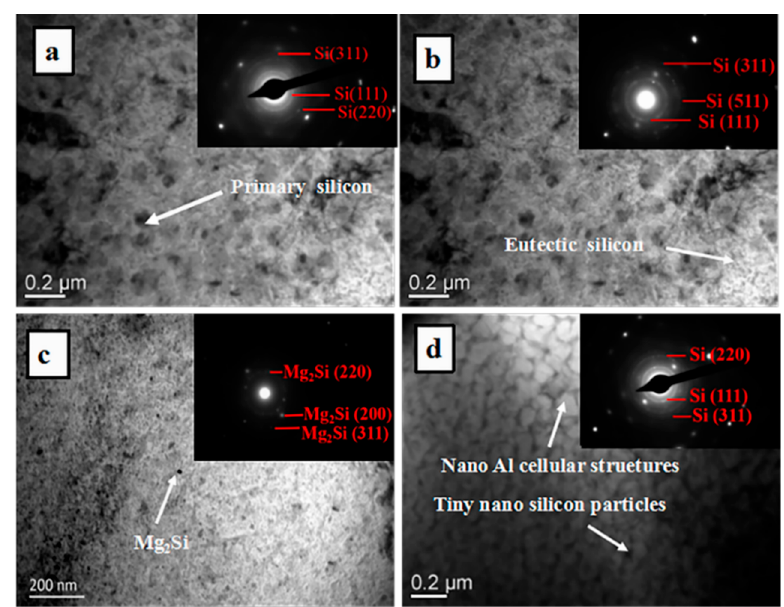
Figure 3. The formation of metastable structures of Al–20Si–5Mg alloy after HCPEB treatment with 25 pulses: ( a ) nano-primary silicon phase and the corresponding selected area electron diffraction (SAED) pattern; ( b ) nano-eutectic silicon phases and the corresponding SAED pattern; ( c ) nano-Mg 2 Si phase and the corresponding SAED pattern; and ( d ) nano Al cellular structures, tiny nano silicon particles, and the corresponding SAED pattern.